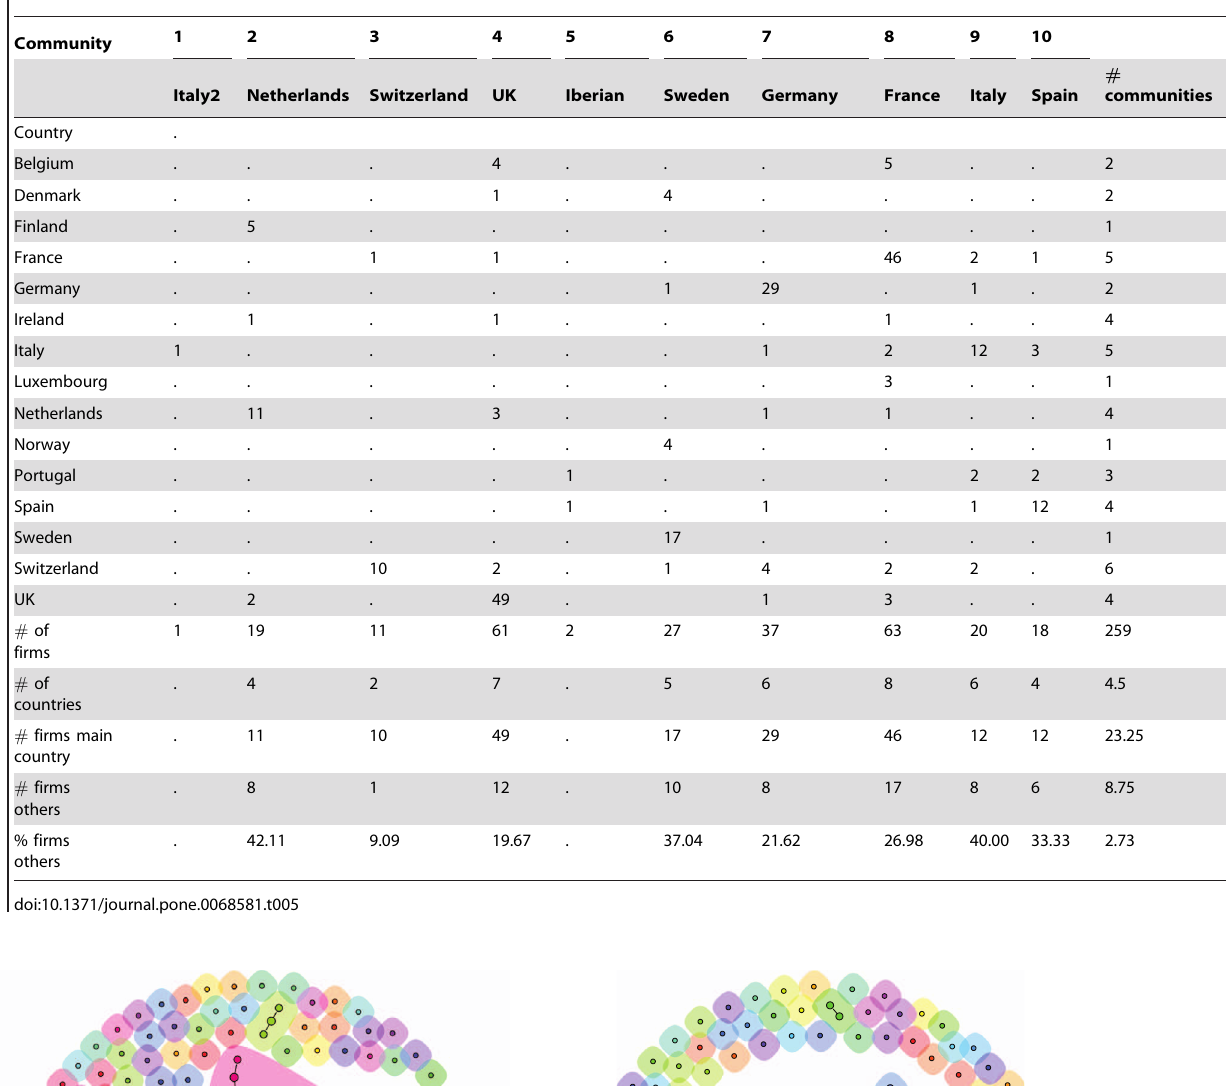
Table 5. Country distribution of the best-found subdivision into communities – Year 2010.